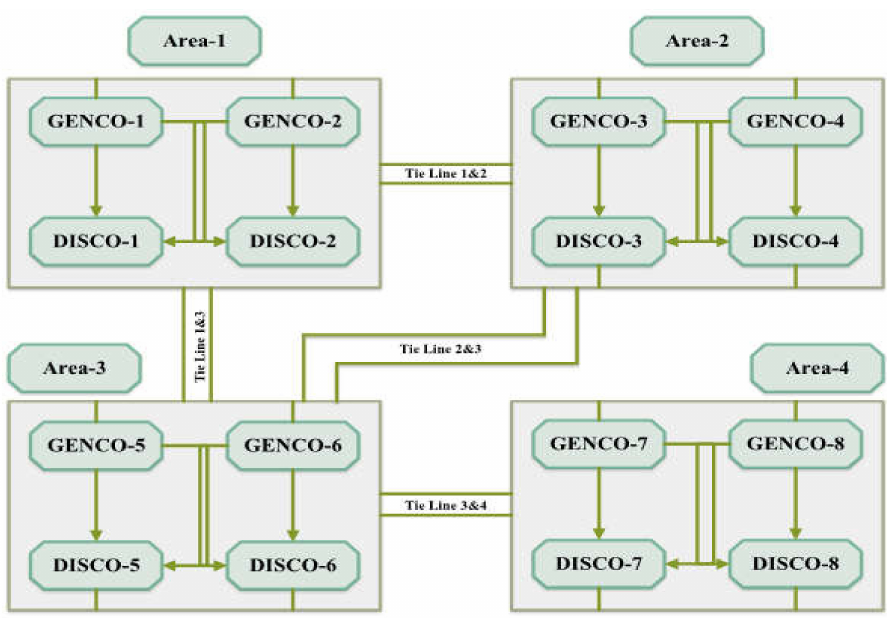
Figure 5. Tie Line Interconnection of